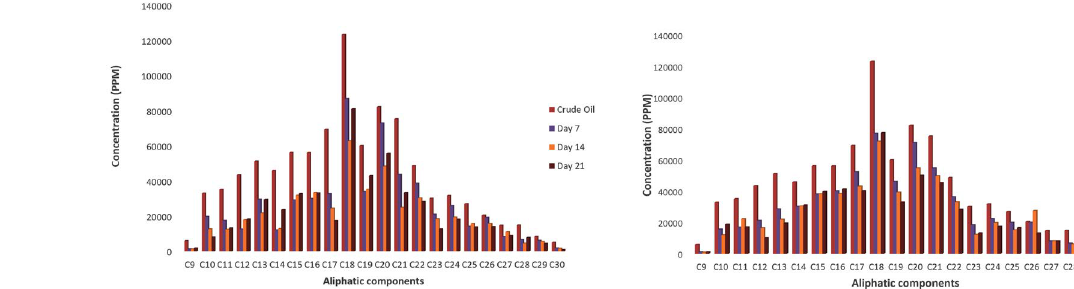
Fig. 4. Concentrations of Aliphatic compounds in residual crude oil from Dyadobacter koreensis culture fluid.